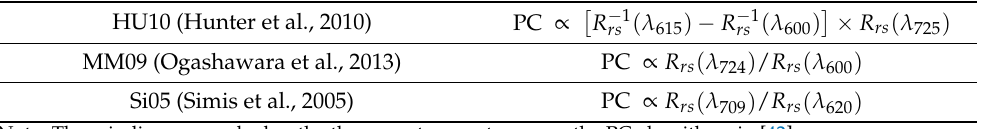
Table 2. Algorithms from existing studies for estimating the PC concentration used for comparison with the proposed